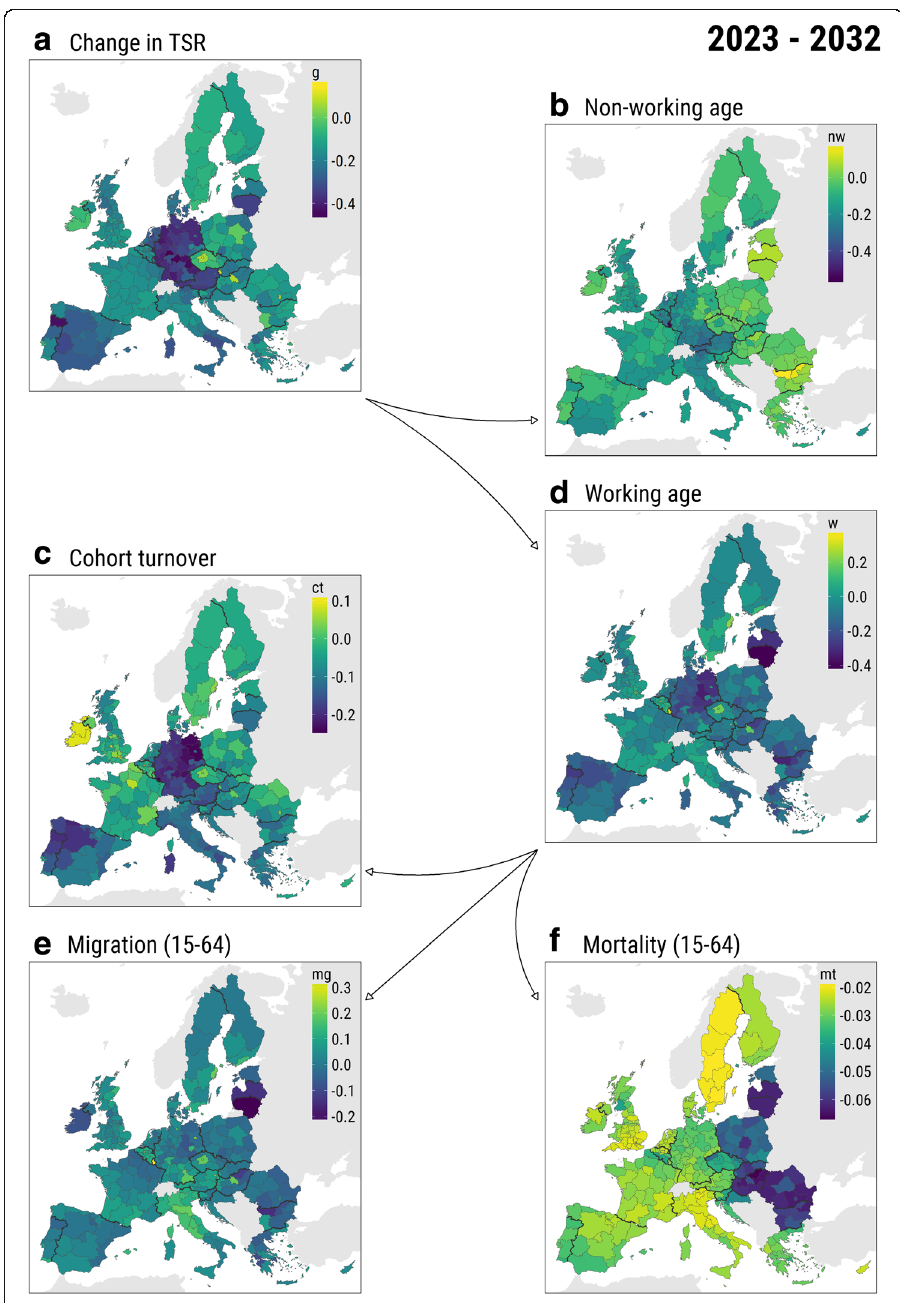
Fig. 8 Decomposition of change in TSR between 2023 and 2033. Notes : a Overall change. b Change due to dynamics in non-working-age population. c Change due to dynamics in working-age population. d Change due to cohort turnover. e Change due to migration at working ages. f Change due to mortality at working ages. Color scales are panel specific due to the big difference in variables ’